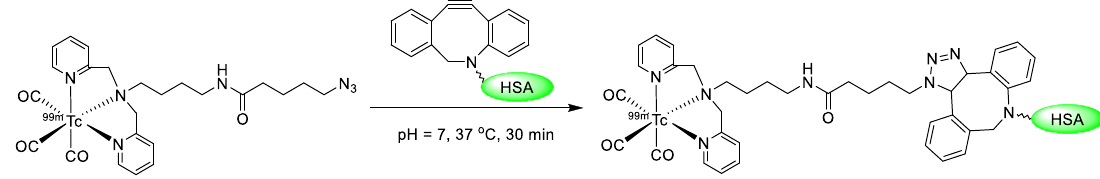
Figure 8. SPAAC for 99m Tc-based radiolabeling of human serum protein.